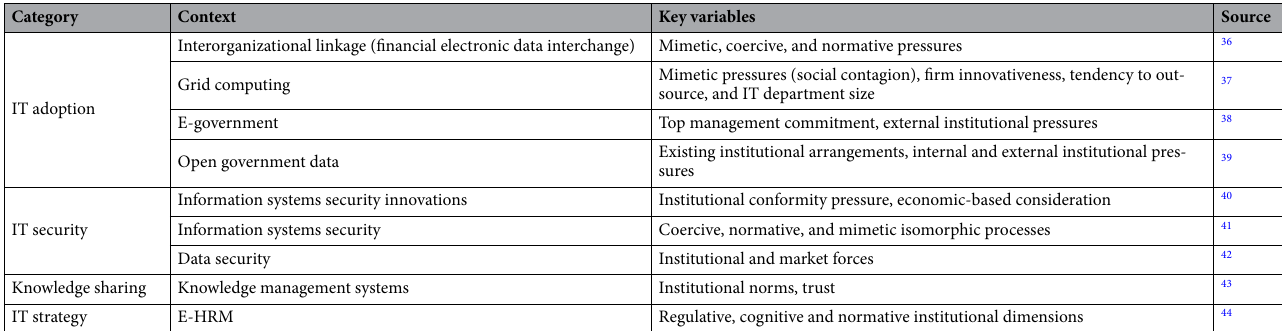
Table 3. Research on institutional theory in the information systems